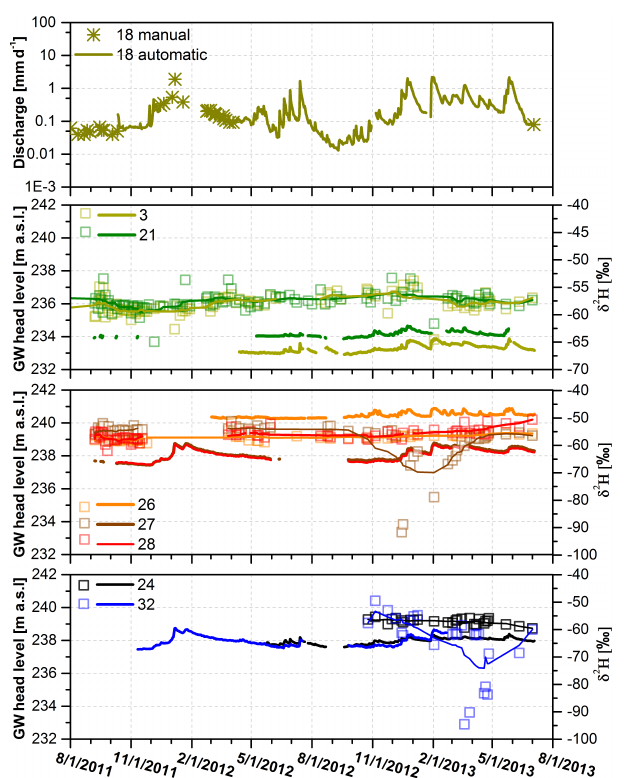
Figure 8. Temporal variation of discharge at the Vollnkirchener Bach with automatically recorded data (solid line) and manual dis- charge measurements (asterisks) (site 18), groundwater head levels, and δ 2 H values (coloured dots) for selected piezometers under the meadow (sites 3 and 21), arable land (sites 26, 27, and 28), and be- side the Vollnkirchener Bach (sites 24 and 32) including moving averages for groundwater isotopes.